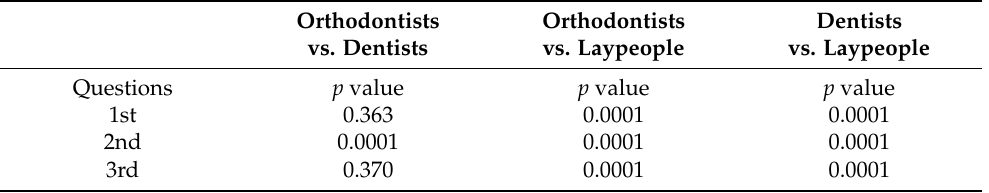
Table 4. Comparisons of the perceptions among the different groups of evaluators for the three different questions at p < 0.016. Orthodontists Orthodontists Dentists vs. Dentists vs. Laypeople vs. Laypeople Questions p value p value p